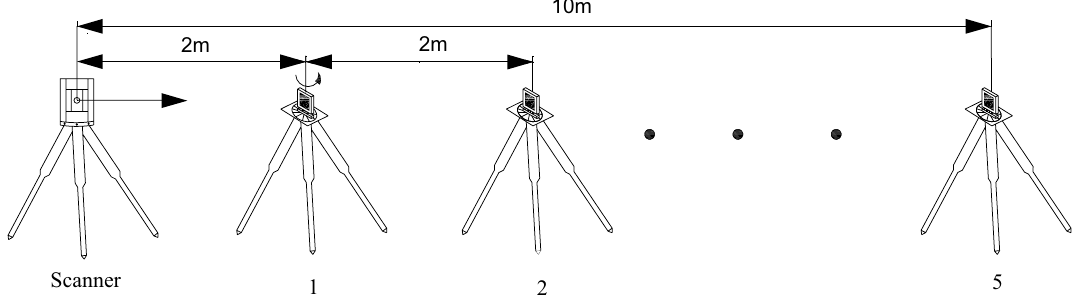
Figure 3. Schematic diagram of monitoring (Software: AutoCAD Application 2020; https:// www. autod esk. com.